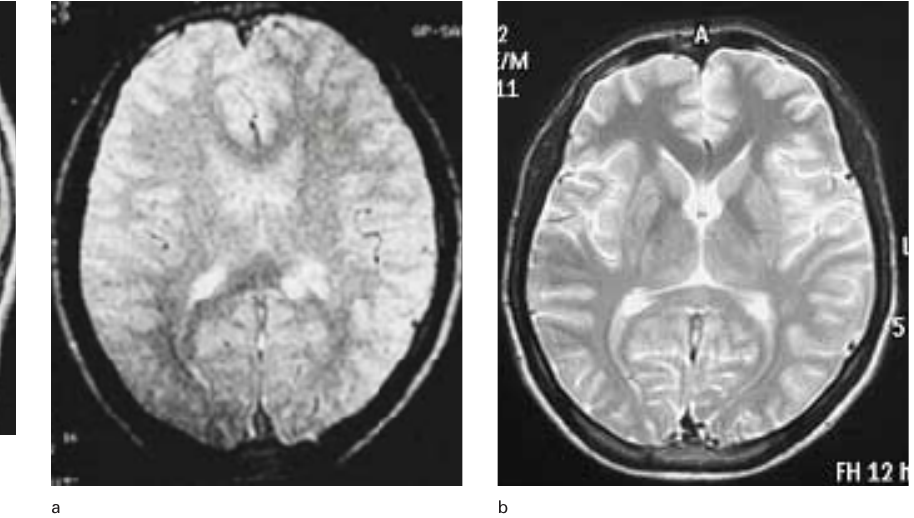
a. Callosal lesion in T2 SE axial image. b. Follow-up MRI shows disappearance of the